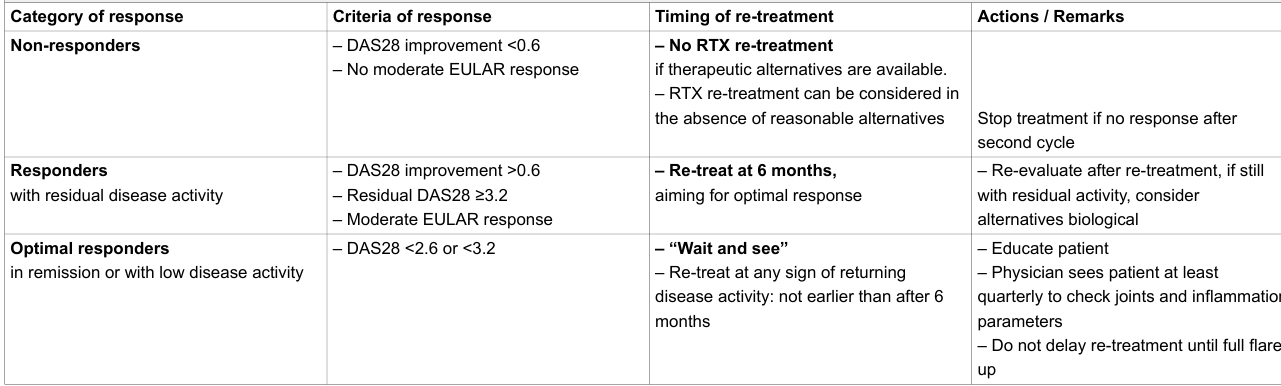
Table 1 Summary of re-treatment algorithms based on initial response